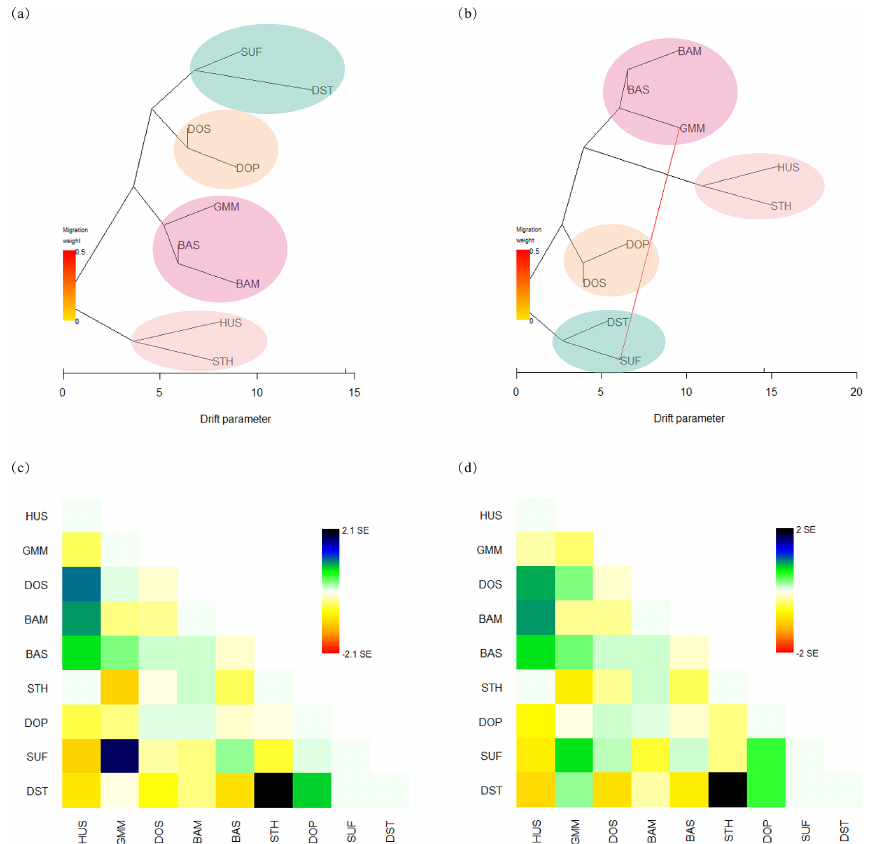
Figure 4. Maximum likelihood trees among nine sheep populations constructed with TreeMix. (a) Maximum likelihood tree without mi- gration events; (b) maximum likelihood tree with one migration event; (c) residual fit without migration events; (d) residual fit with one migration